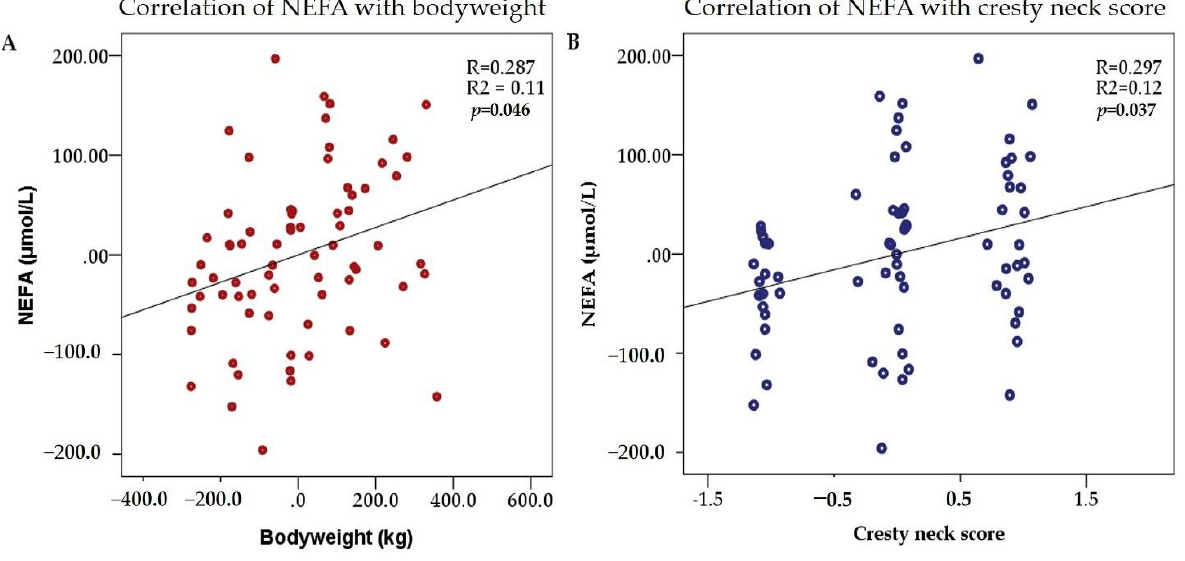
Figure 2. Correlation between NEFA and bodyweight ( A ) and cresty neck score ( B ). The dots represent correlations between the 2 parameters.